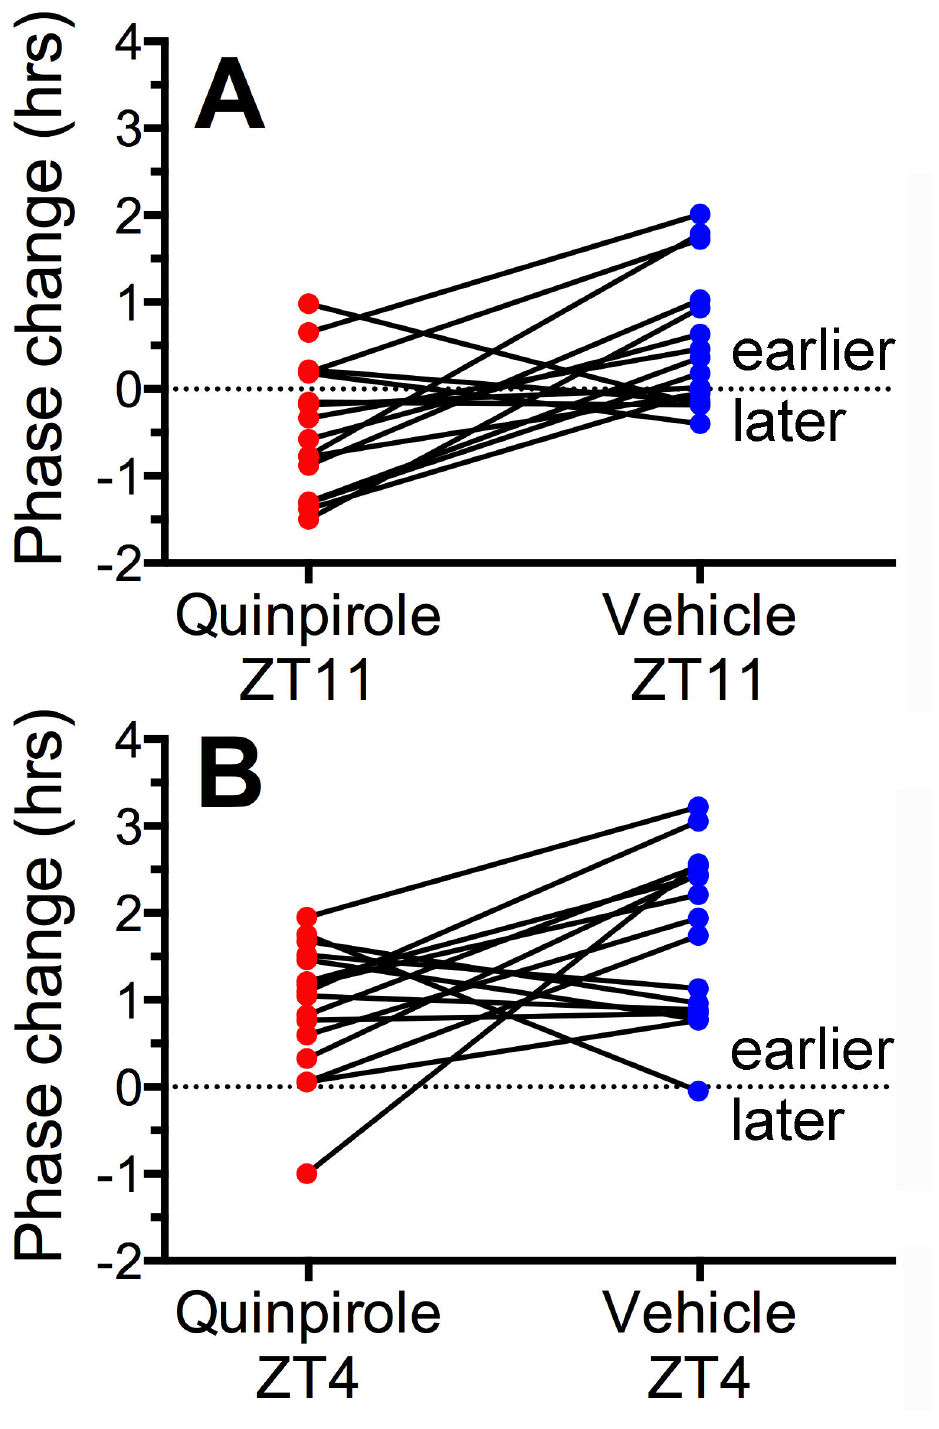
Figure 3. Changes in the timing of food anticipatory activity following quinpirole (1 mg/kg; red dots) or vehicle injections (blue dots) administered on the previous day at ZT11 (1h before lights off) or ZT4 (4h after lights-on) in Experiment 1. Each data point represents the difference in hours between food anticipatory activity onset on the day following injections compared to food anticipatory activity onset averaged over the 4 days preceding the injections. Positive values indicate phase advances (earlier onset of activity) and negative values indicate phase delays (later onset of activity). Within-subject pairs are connected by lines, illustrating that in most rats, activity onsets were delayed following quinpirole injections relative to vehicle injections. doi: 10.1371/journal.pone.0082381.g003 PLOS ONE |